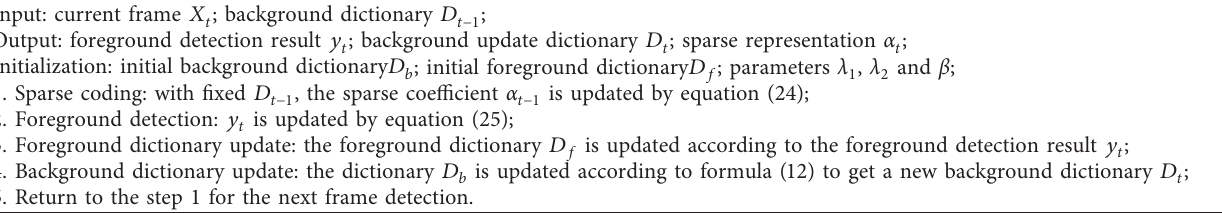
Table 1: Traffic foreground detection algorithm for intersection